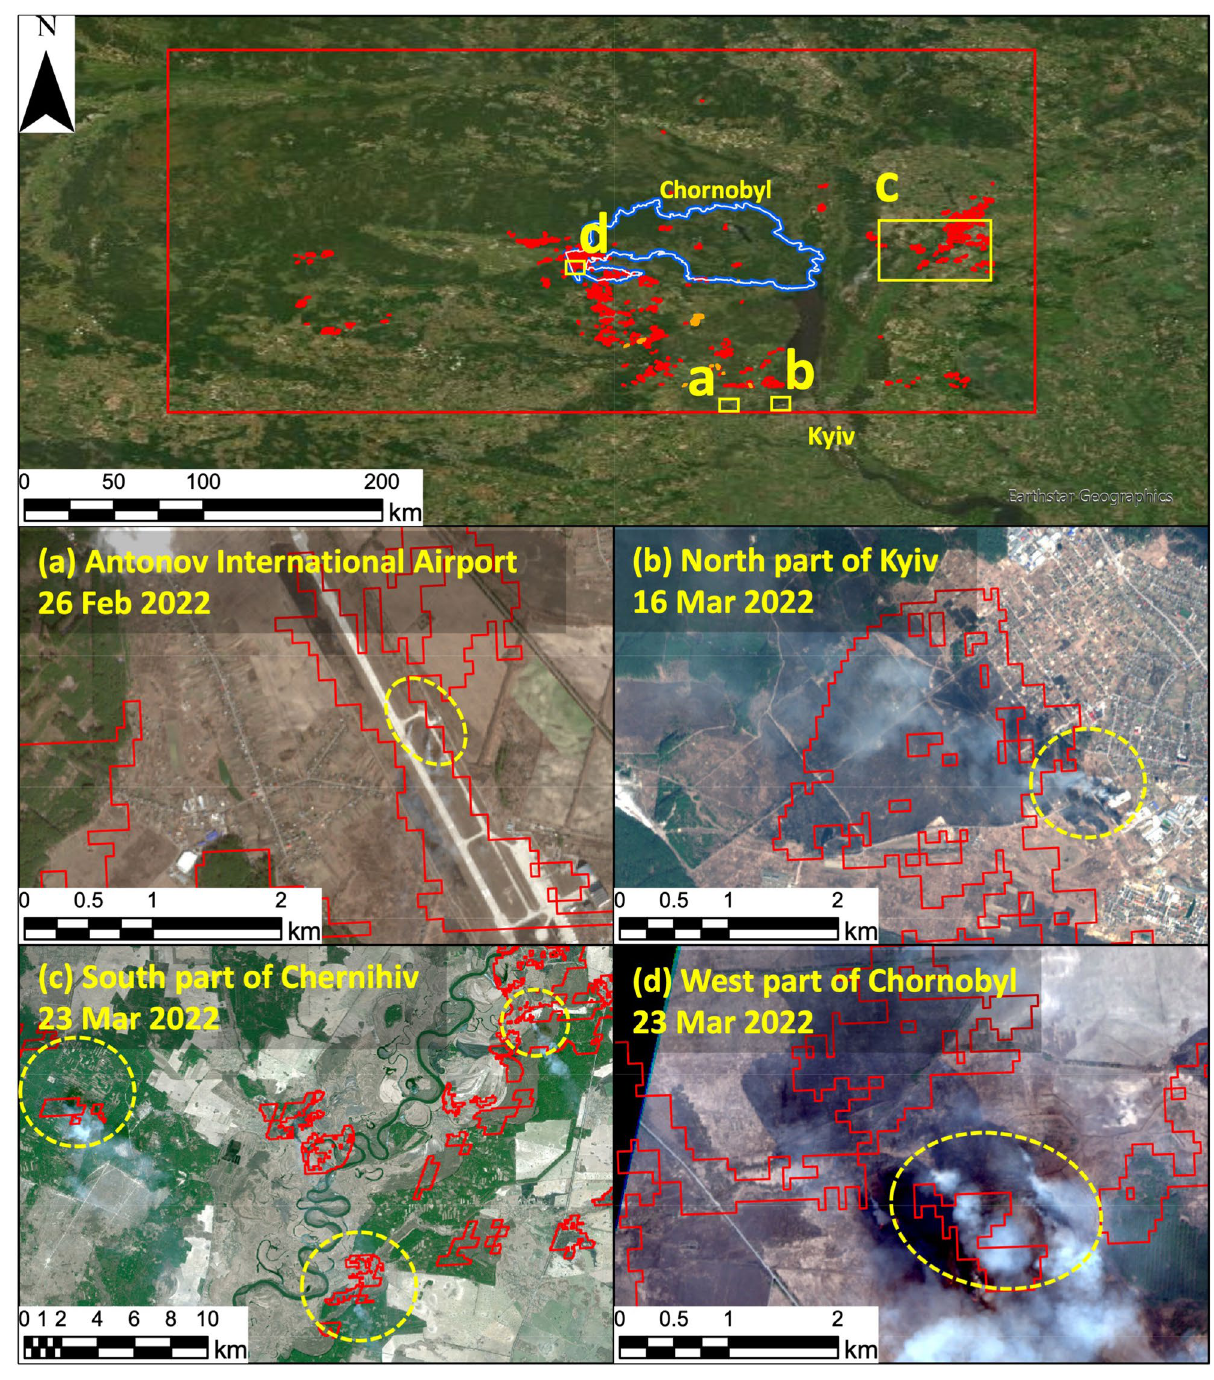
Figure 2. Detected burned area in February and March 2022 at the northern part of Ukraine. Orange and red line area indicate the detected burned area in February and March 2022, respectively. The blue lines indicate the border of Chornobyl exclusion zone. Red solid lines and yellow dash lines indicate the detected burned areas and the actual wildfire areas and smokes confirmed by